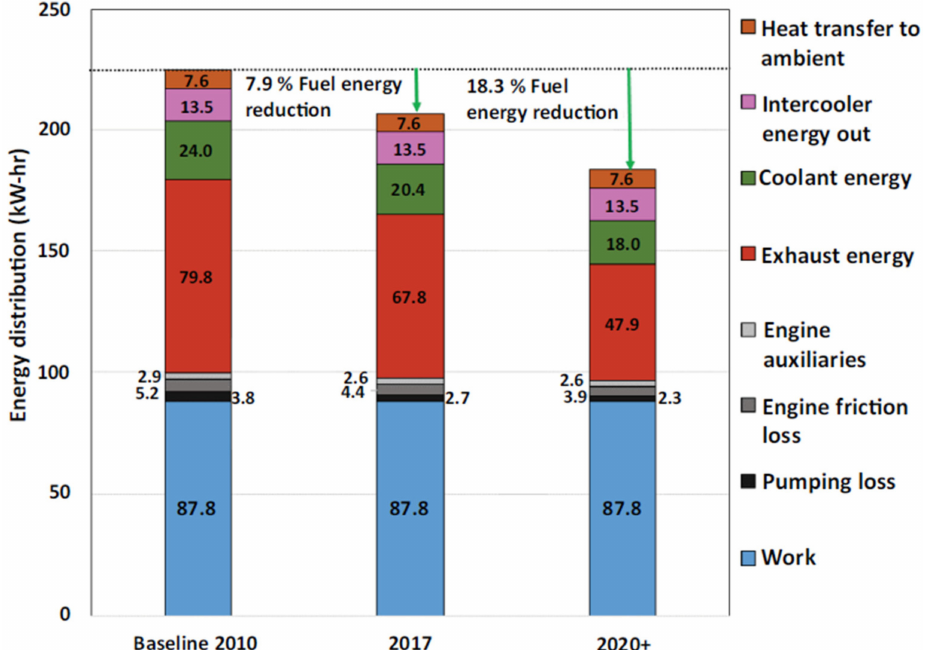
Figure 14. Efficiency gain for an HD engine over the supplemental emissions test (SET) cycle for the baseline, 2017, and 2020–future engine technology